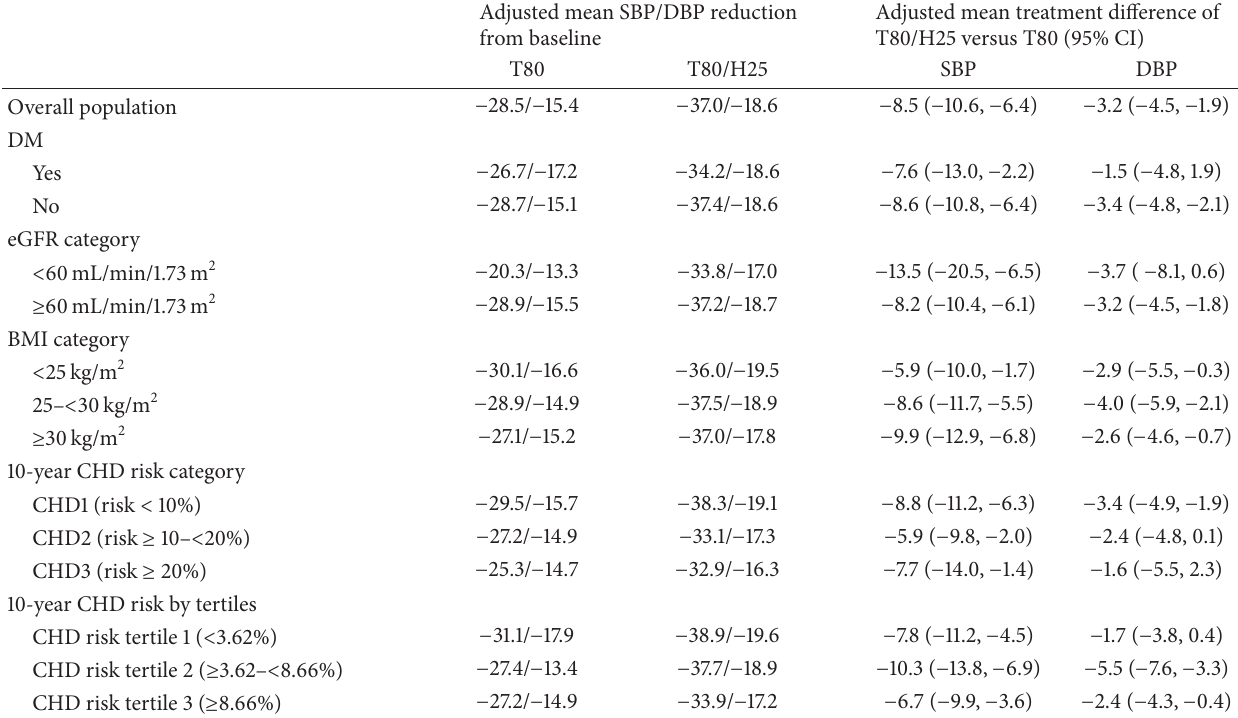
Table 3: SBP and DBP reductions (mmHg) from baseline to Week 7 in overall patient population and different patient subgroups, based on the